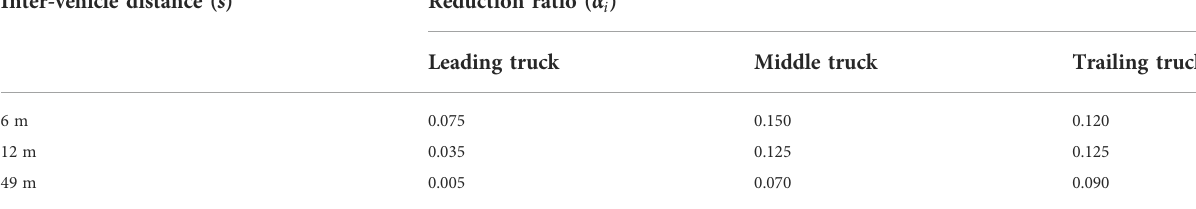
TABLE 1 Reduction ratio of fuel consumption ( α i ) by platooning for each truck (Cases 1 and 2 only). Inter-vehicle distance ( s